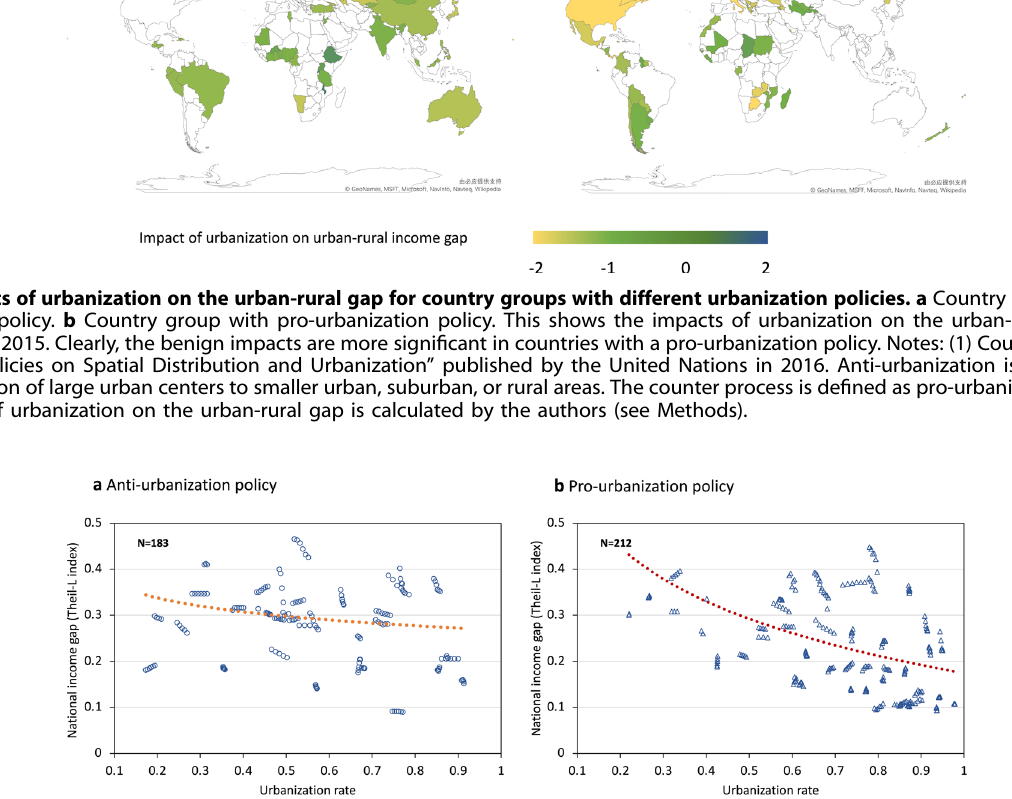
Fig. 9 Impact of urbanization on national income inequality by country groups with different urbanization policies. a Country group with anti-urbanization policy. b Country group with pro-urbanization policy. This further examines how urbanization policies affect national income inequality. The plots are based on data from 90 economies for the period of 2011 – 2015 and indicate that pro-urbanization countries have a larger benign impact of urbanization on national income inequality. Notes: (1) Country grouping is based on “ Policies on Spatial Distribution and Urbanization ” published by the United Nations in 2016. Anti-urbanization is de fi ned as the decentralization of large urban centers to smaller urban, suburban, or rural areas. The counter process is de fi ned as pro-urbanization policy. (2) National income inequality is calculated by the authors (see